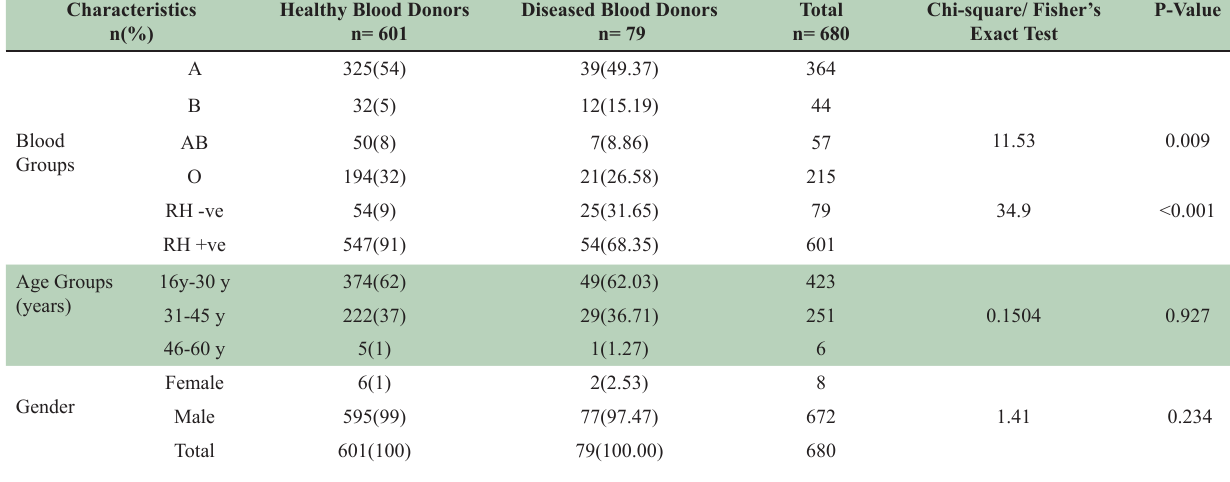
Table-I: Blood Donor Demographic